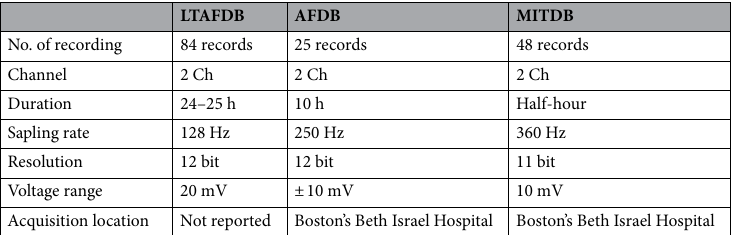
Table 1. Description of three different databases, LTAFDB, AFDB, and MITDB.